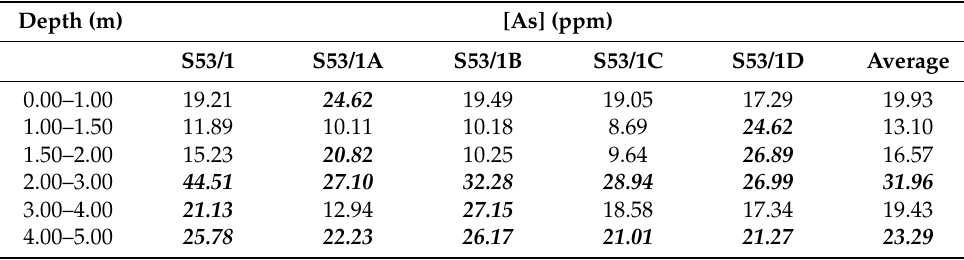
Table 3. Results for the total As in the six levels of the five cores of point S53 and its narrow surroundings. The last column shows the average values for each level of the soil cores. Values above the tolerability limit of 20 ppm, as required for areas intended for public green use and private and residential use by Decree of the Italian Environment Ministry n. 471 of 1999, are highlighted in bold.